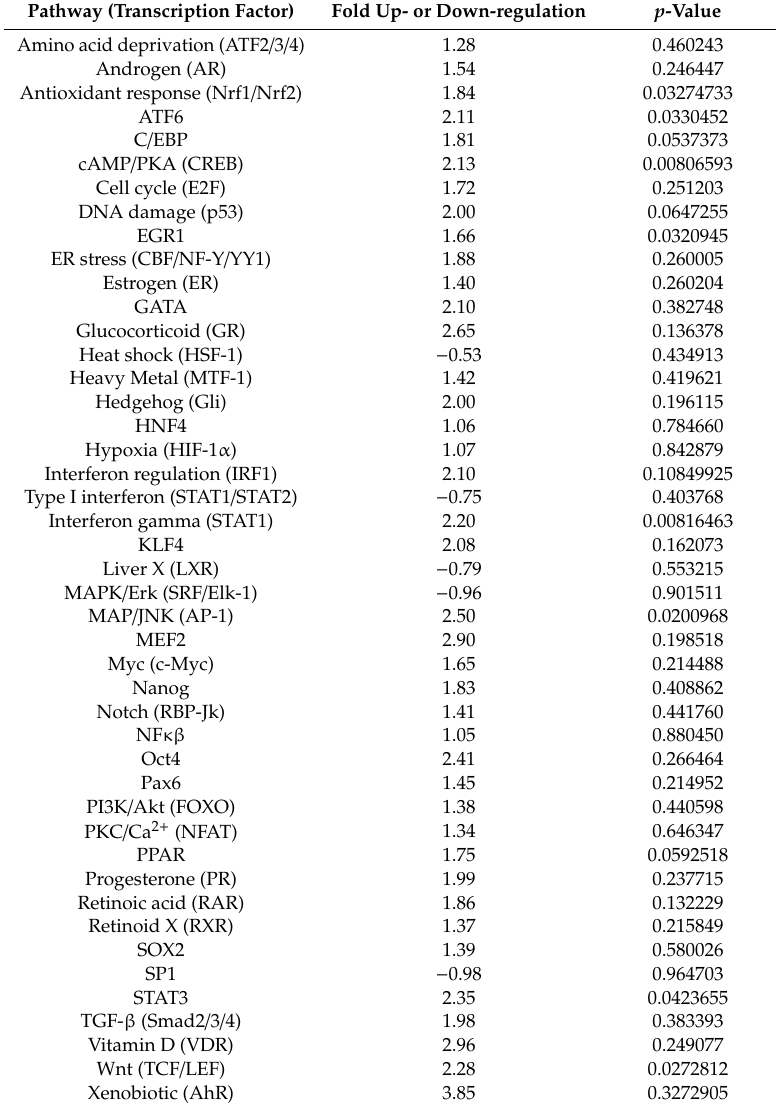
Table 1. Cignal 45-Pathway Reporter Array